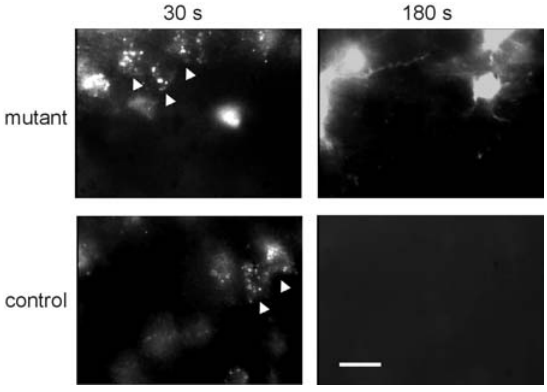
Figure 4. Mutant astroglial NOS activity is unaffected by NOS2 inhibitor. Example images from slices incubated in the selective NOS2 inhibitor 1400W (3 m M) for at least 30 minutes. At 30 seconds from the beginning of illumination (left panels), neuronal punctate fluorescence (arrow heads) was abundant in slices from either mutant or control mice. At 180 seconds (right panels), astrocytic diffuse fluorescence is abolished in slices from control mice, but not in mutant slices. Images were taken with ND4 filter to slow the response and allow for cells’ separation. Scale bar=20 m m.